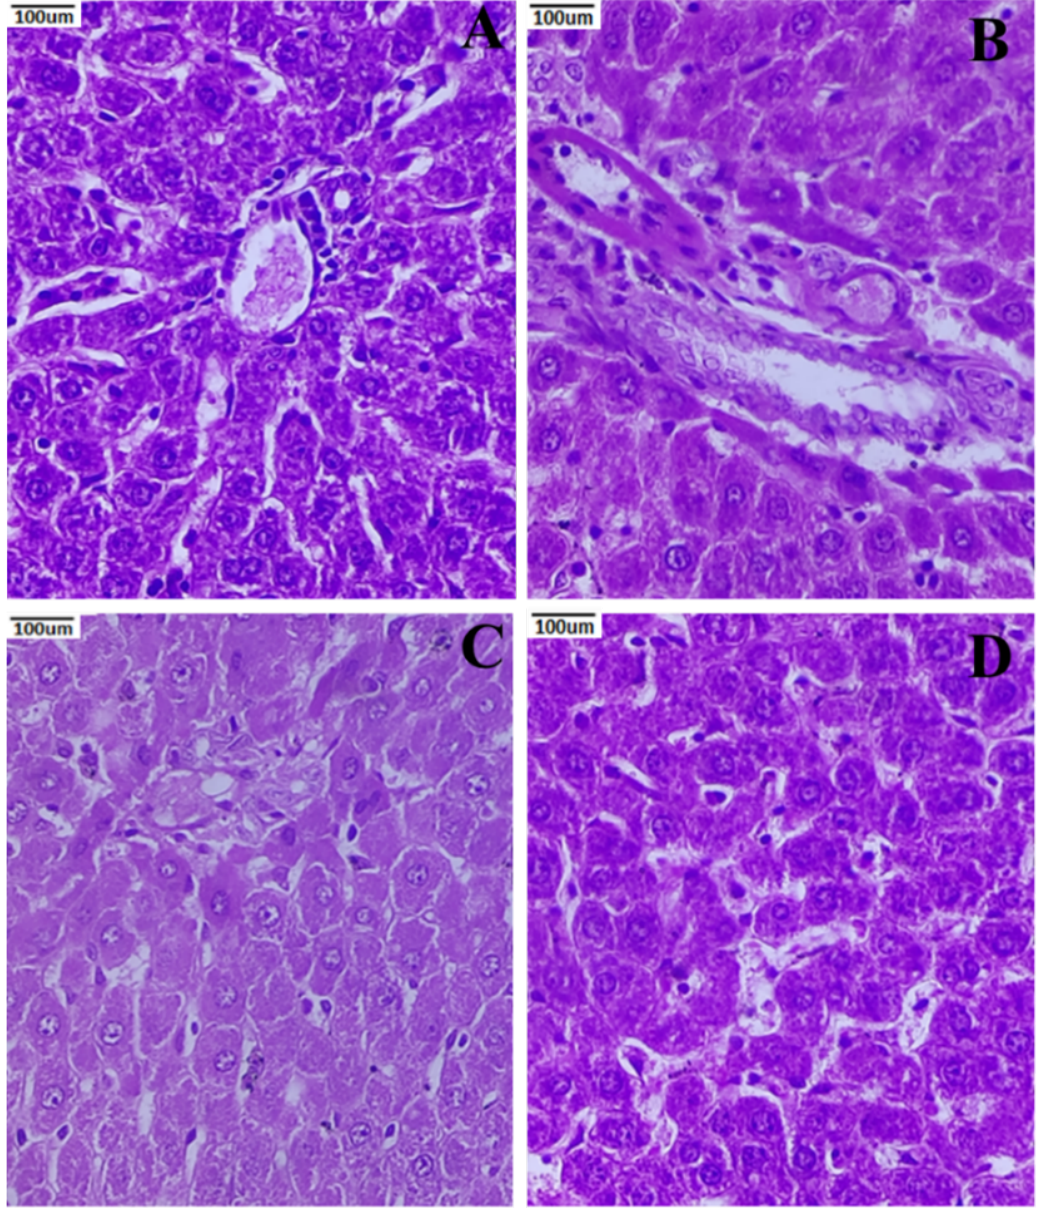
Figure 9. Activities of PCNPs on the liver histopathological picture of DN rats (40×). ( A ) Normal photomicrograph shows hepatocytes arranged in the form of cords and the central vein; ( B ) DN liver showing feathery degeneration, micro- and macrovesicular fatty changes, periportal fibrosis, and vascular congestion; ( C ) STZ + PCNP-treated group of rats shows nearly normal hepatic anatomy; ( D ) 80 mg/kg of PCNPs only shows cells with normal histology.